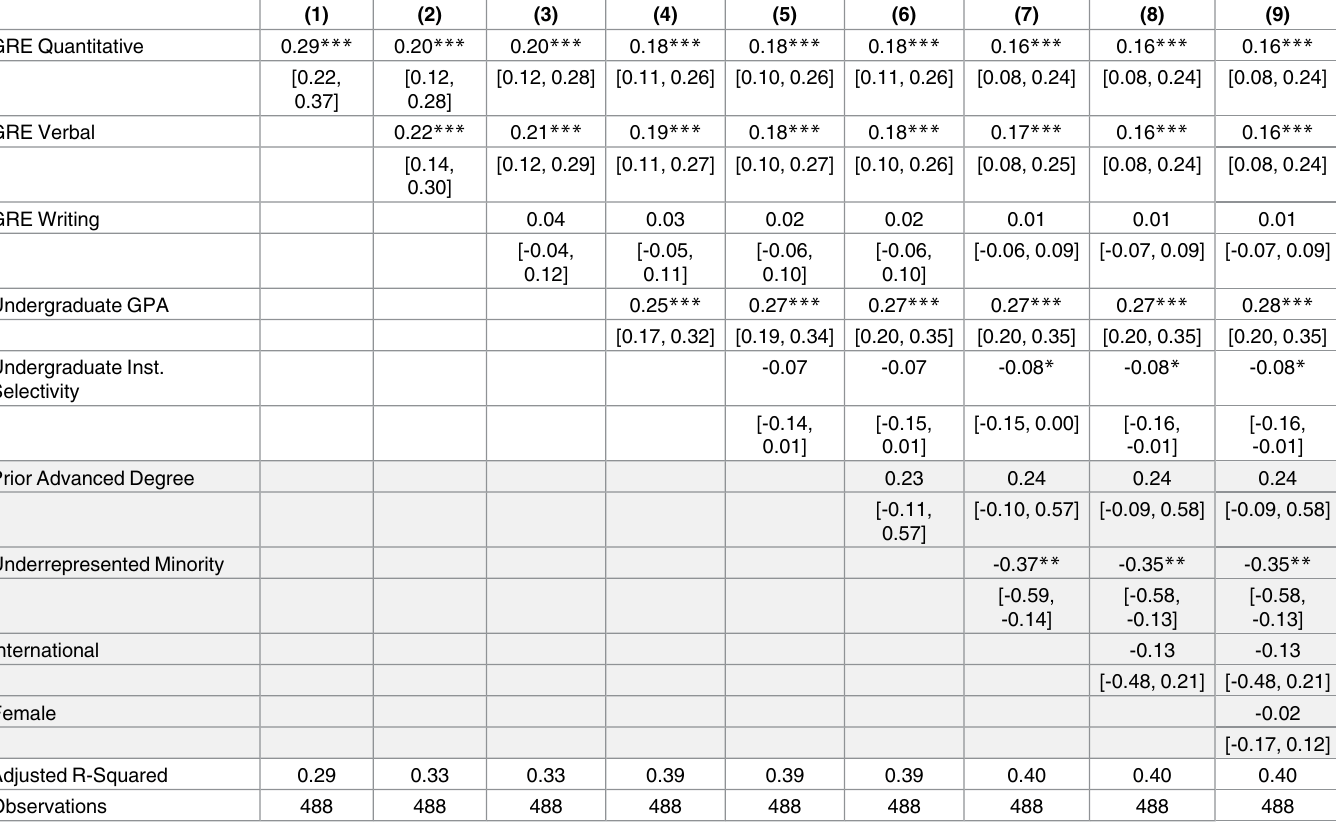
Standardized regression coefficients and 95% confidence intervals are reported for continuous variables. Coefficients on the binary variables are shaded gray and report the standard deviation change in the outcome by moving from 0 to 1 on the binary variable. Cohort fixed effects are included for each model. Adjusted R-squared is presented for each